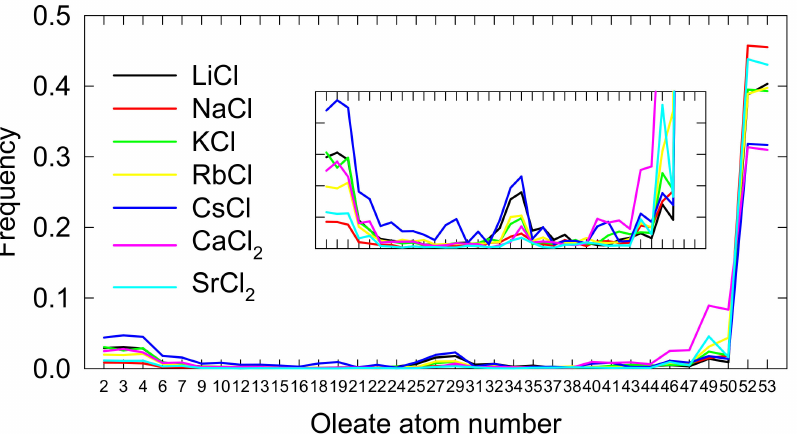
Figure 8. Frequency of atomic interactions between oleate and spodumene. For the identification number of the oleate atoms see Figure 1. Carbon atoms are omitted in the figure. The interaction is dominated by bridges through the carboxylate group of the oleate. Inset: the highlight of much less frequent contacts, the double bond and the nonpolar tail of the